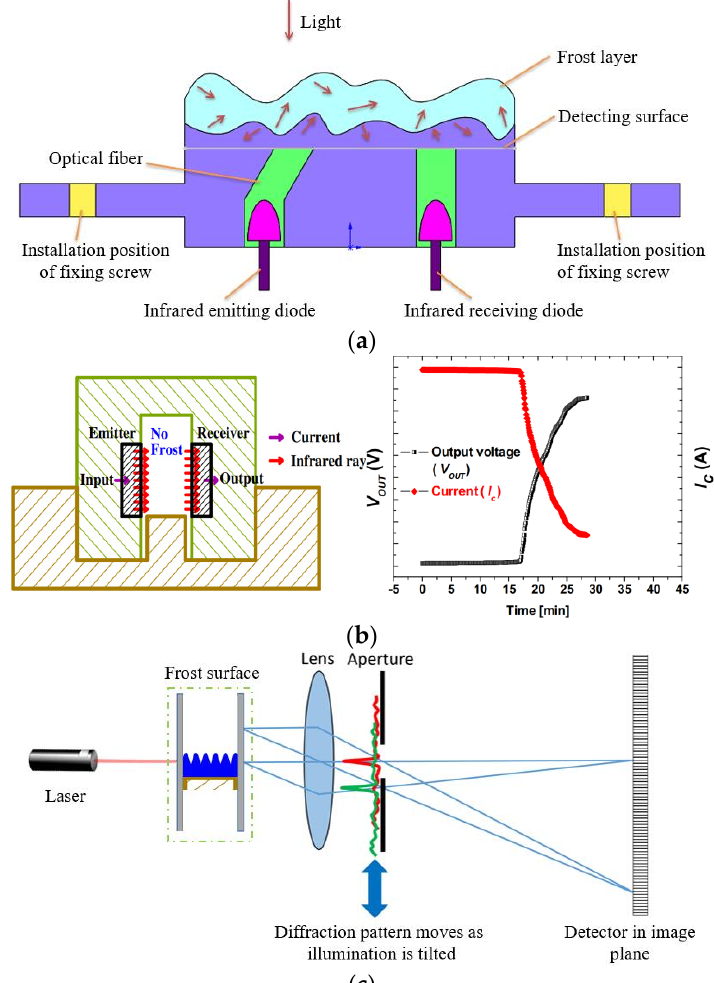
Figure 7. Frost detection methods based on light scattering, light transmission, and light diffraction principles: ( a ) scattered light detection; ( b ) transmission light detection; ( c ) diffraction light detection.